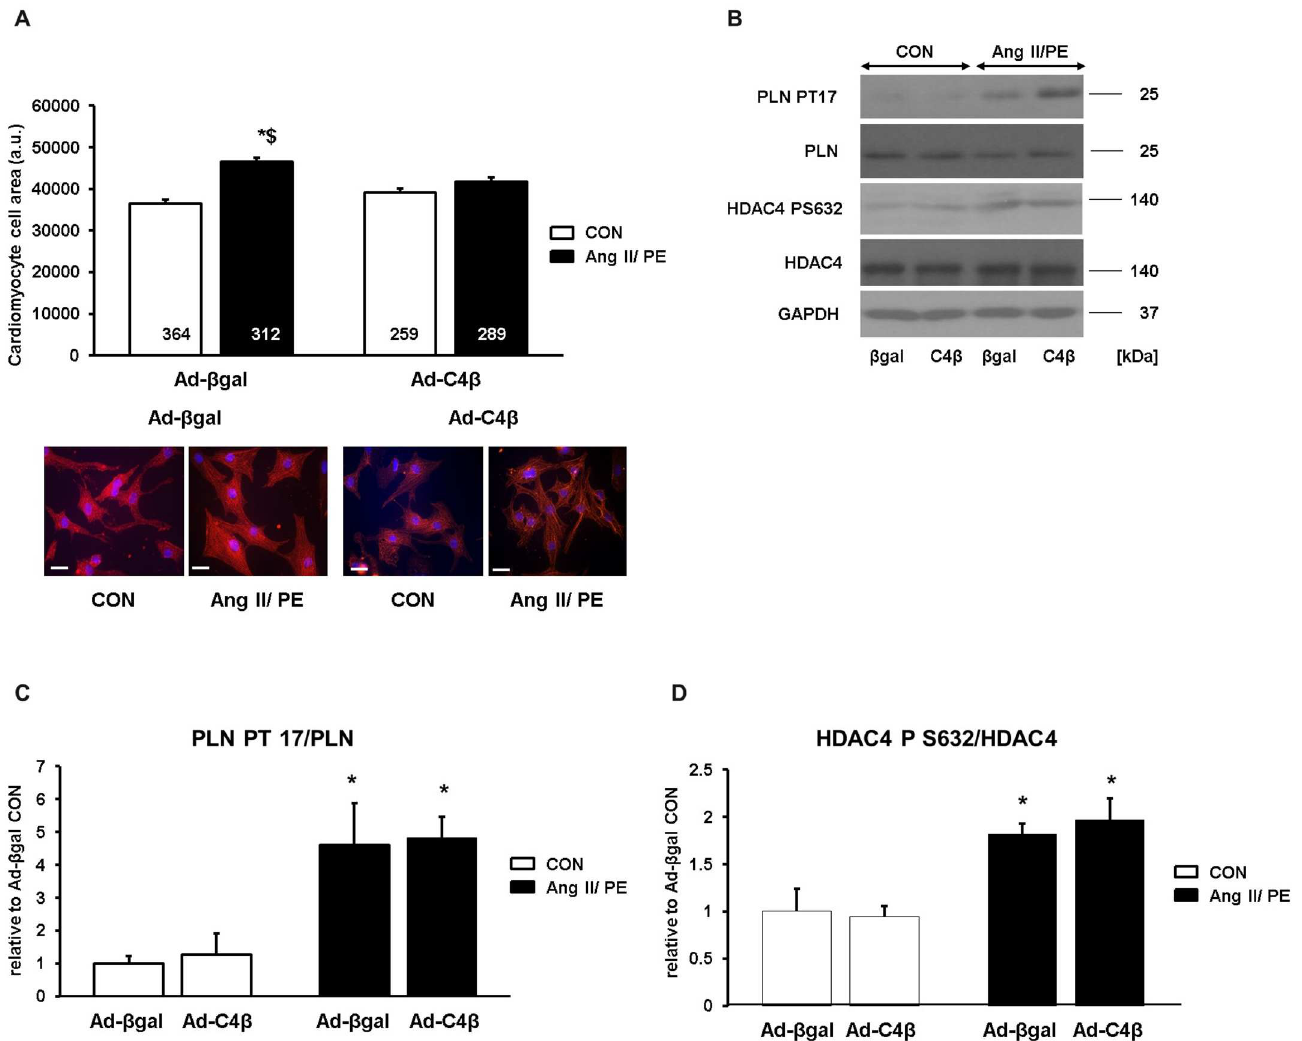
Fig 8. TRPC4 β attenuates hypertrophic growth in cardiomyocytesafter GPCR stimulation. A, Hypertrophic growth of cardiomyocytes was measuredas an increaseof the cell surface after angiotensin II/phenylephrine (Ang II/PE) or vehicle(CON) treatment for 24 h. Red: α -actinin; Blue: DAPI. * P < 0.05vs Ad- β galCON; $ P < 0.05vs Ad-C4 β AngII/PE. Cells from three different experiments were analyzed.Scale bar: 20 μ m. N-numberof cells is indicatedin the bars. B, Expression and phosphorylation of phospholamban (PLN) and histonedeacetylase4 (HDAC4) in Ad- β galand Ad- TRPC4 β NRCs after stimulation with Ang II/PE or vehicle(CON) for 24 h. phospho-PLN: PLN PT17; phospho-HDAC4: HDAC4 PS632; glyceraldehyde 3-phosphatedehydrogenase: GAPDH. Shownare representative immunoblots from three different experiments. C, Average quantifiedvalues of PLN PT17 signalsexpressedrelative to Ad- β galCON for n = 3 experiments. D, Average quantifiedvalues of HDAC4 PS632 signalsexpressedrelative to Ad- β galCON for n = 3